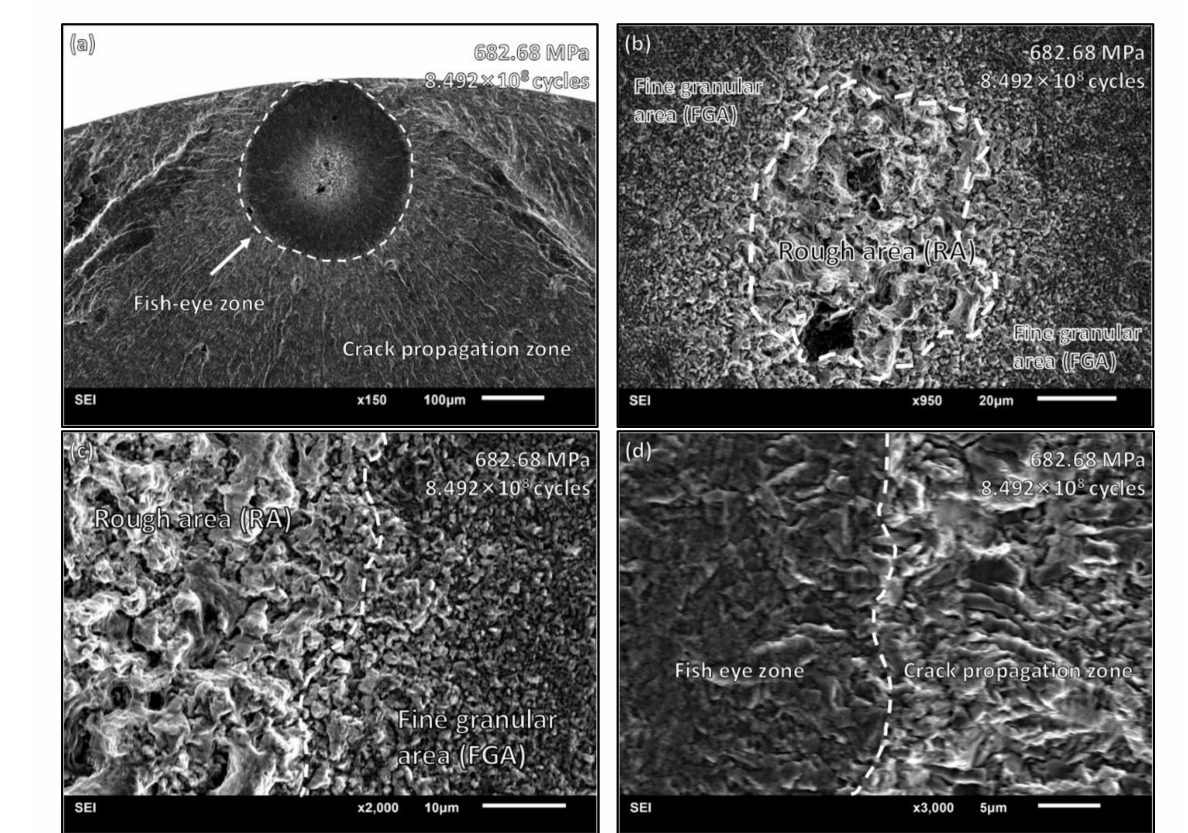
Figure 8. VHCF fracture morphology with FGA: ( a ) a typical fish-eye zone in VHCF state; ( b ) RA with internal inclusions and FGA around RA; ( c ) boundary of RA. Particle size decreases rapidly from RA to FGA; ( d ) boundary of fish-eye zone. Different crack patterns are shown in these two areas.